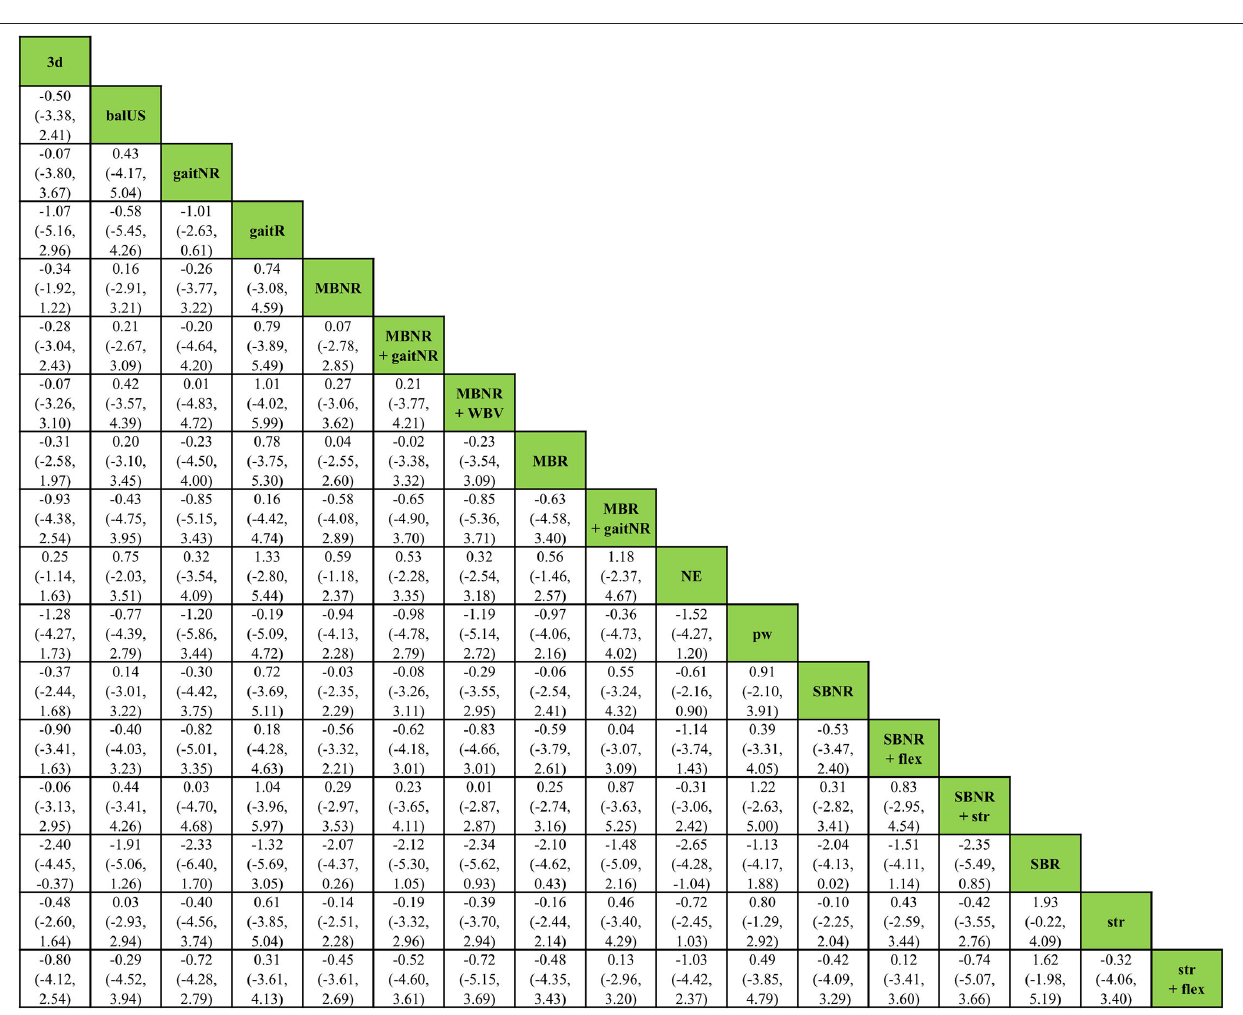
FIGURE 4 | Relative effect estimates with 95% credible intervals of all pairs of exercise